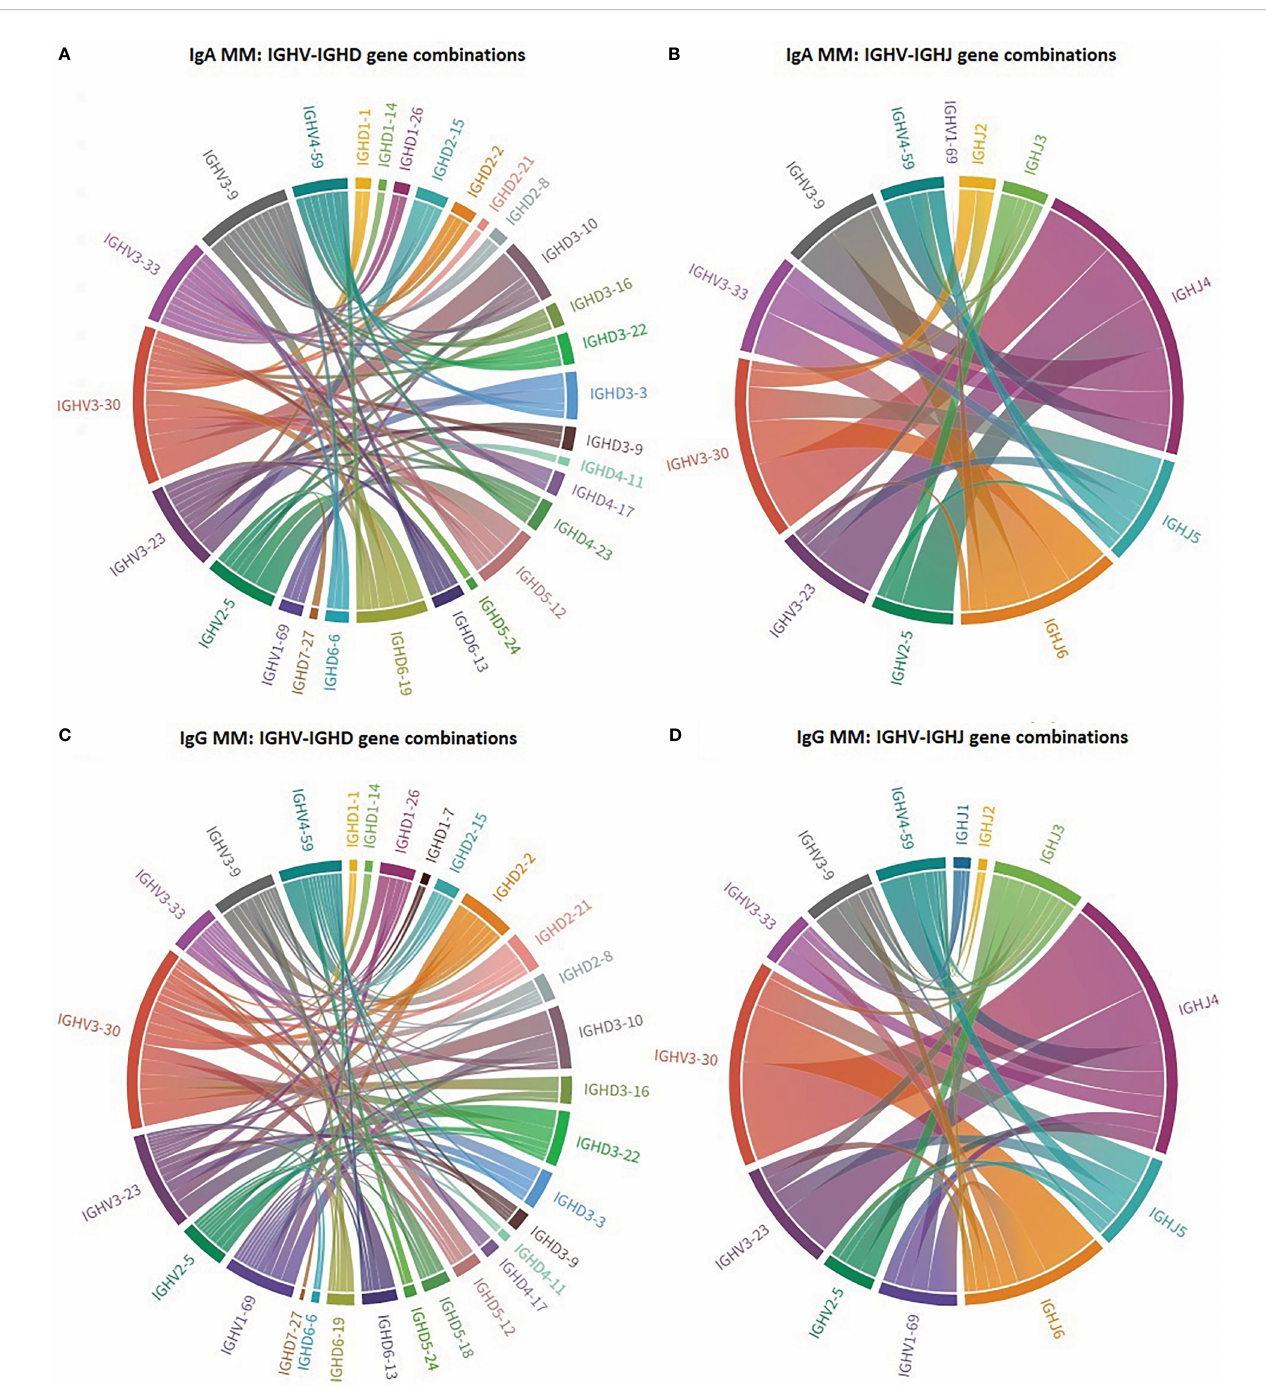
FIGURE 2 Biased IG gene pairings in multiple myeloma. Circos plot presenting IGHV-IGHD-IGHJ combinations of the 7 most frequent IGHV genes in IgA MM and IgG MM. The Circos software package was used to depict the predominant combinations between IGHV and IGHD genes [ (A) IgA and (C) IgG patients] as well as between IGHV and IGHJ genes [ (B) IgA and (D) IgG patients] in both MM